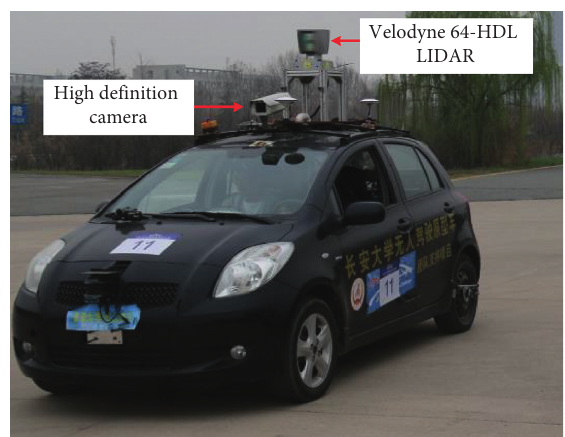
Figure 4: Autonomous vehicle.